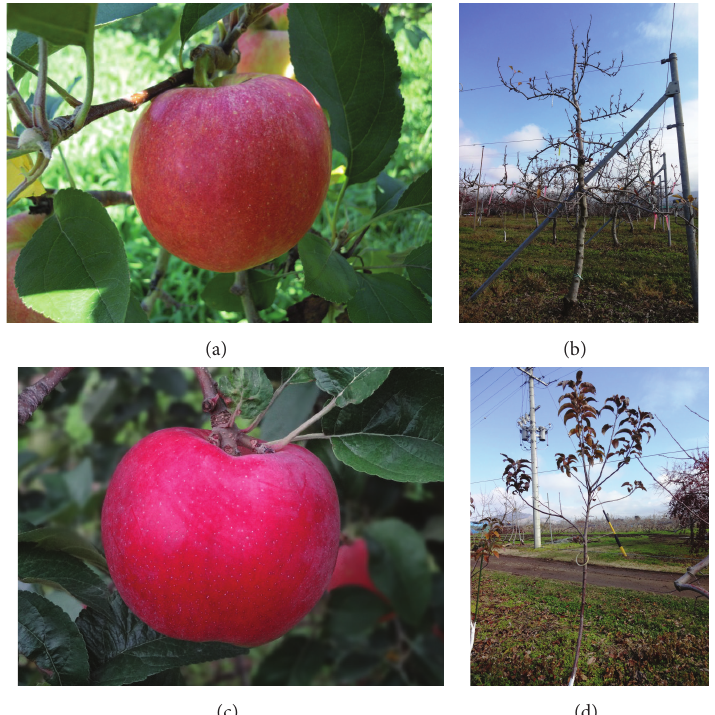
Figure 1: A mature fruit and a shape of tree of “Natsuotome” ((a), (b)) and “Swakko” ((c), (d)) produced at Nagano Fruit Tree Experiment